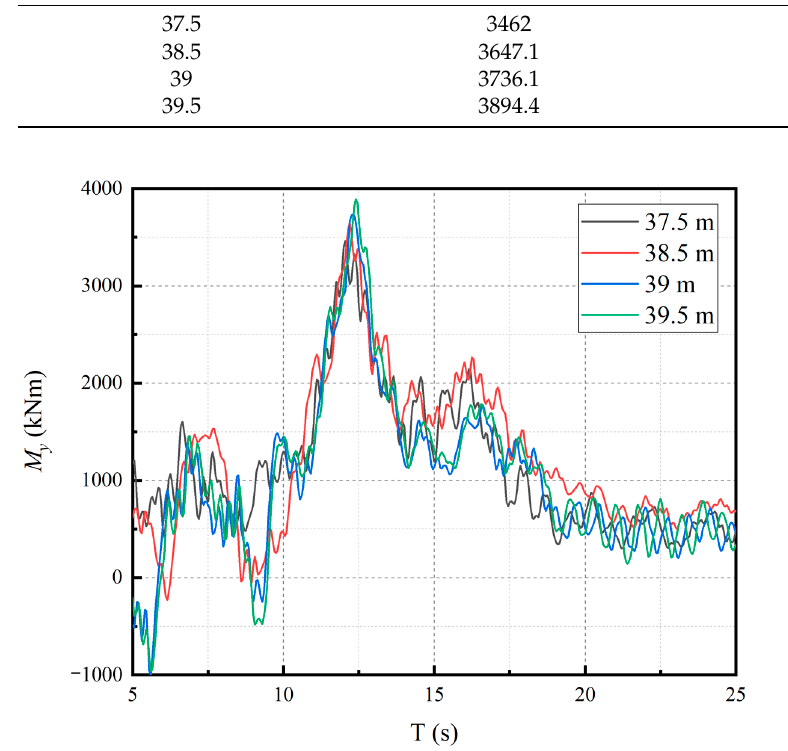
Figure 11. Load time series of M y at blade root.